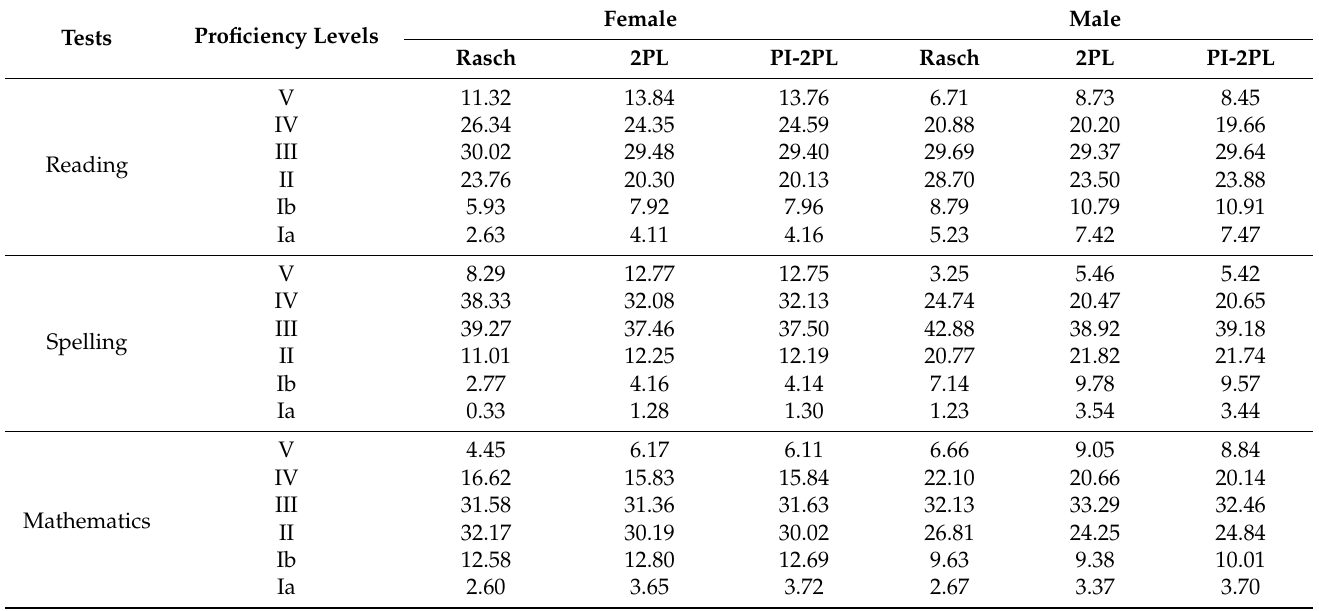
Table 7. The proportion (%) of the students at each proficiency level, by gender